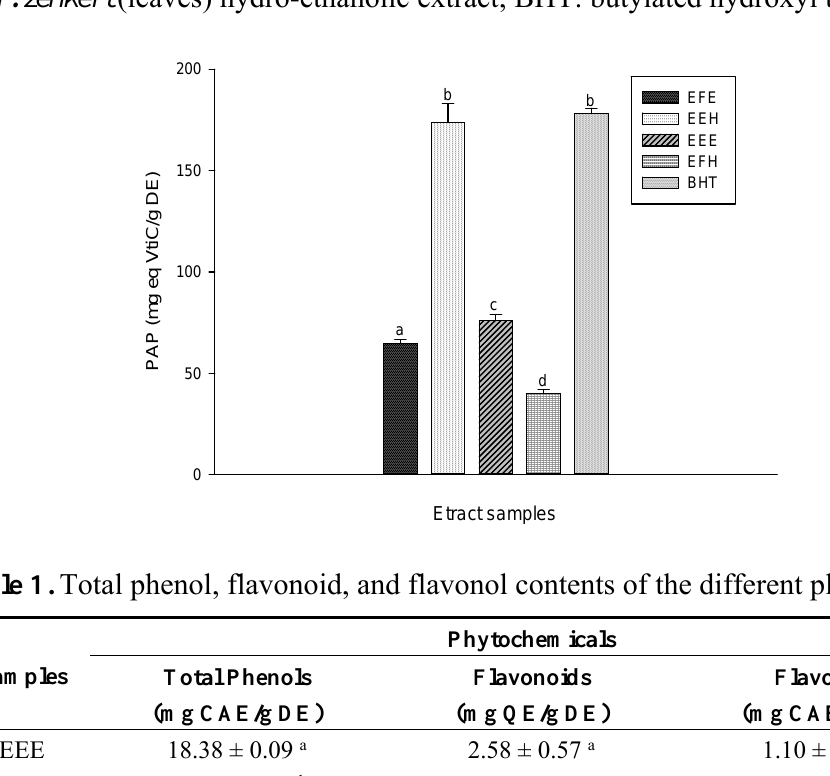
Figure 7. Phosphomolybdenum antioxidative power (PAP) of the different plant extracts. Values are expressed as mean ± SD of three replicates. The values labeled with different letters differ significantly at p < 0.05. EEE: H. zenkeri ( bark) ethanolic extract; EFE: H. zenkeri (leaves) ethanolic extract; EEH: H. zenkeri (bark) hydro-ethanolic extract; EFH: H. zenkeri (leaves) hydro-ethanolic extract; BHT: butylated hydroxyl toluene.